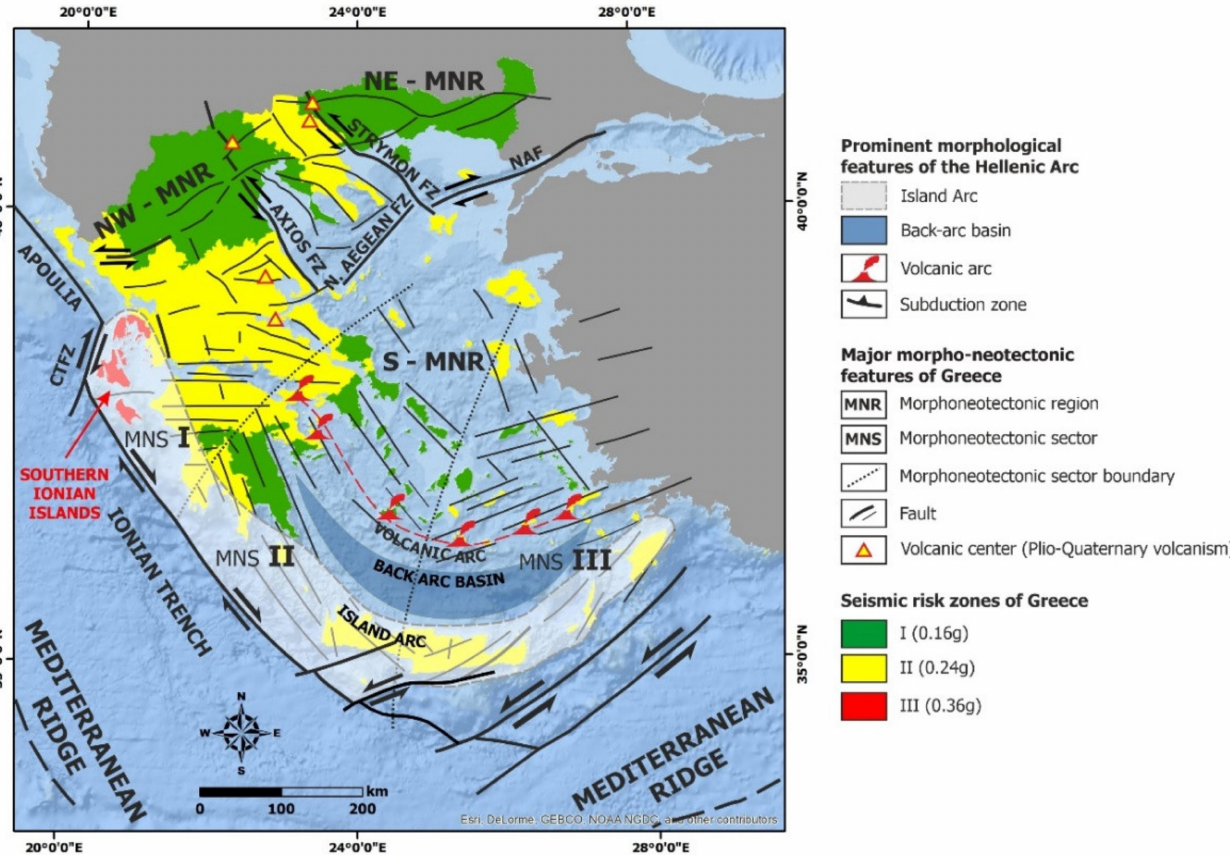
Figure 1. Map of the Hellenic Arc showing the location of the southern Ionian Islands at the northwesternmost part of the Hellenic Arc, along with the prominent morphological features of the Hellenic Arc and the major morphoneotectonic features based on Mariolakos and Papanikolaou [23,24] and the seismic risk zones of Greece. The southern Ionian Islands belong to the zone III of the current Greek Building Code with a peak ground acceleration (PGA) value of 0.36 g for a return period of 475